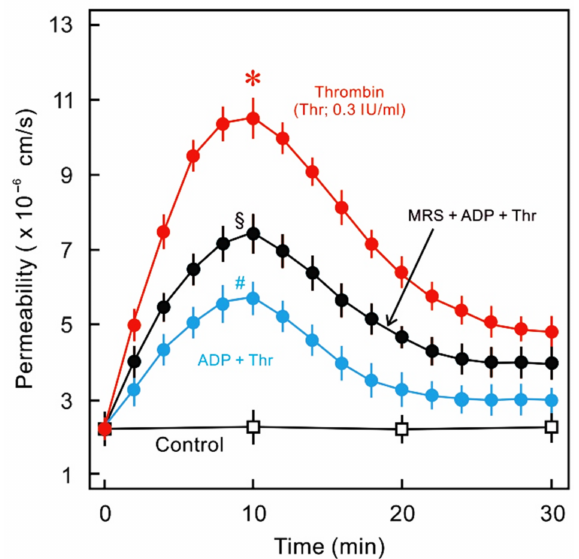
Figure 4. Effect of ADP and P2Y 1 antagonist (MRS2500) on thrombin-induced endothelial hyperper- meability: HUVEC monolayers cultured on filter membranes were exposed to human thrombin (Thr, 0.3 IU/mL) in the absence (red) or presence (blue) of P2Y 1 receptor agonist ADP (10 µ M), and the flux of labelled albumin was measured as described previously [84]. In a parallel set of experiments P2Y